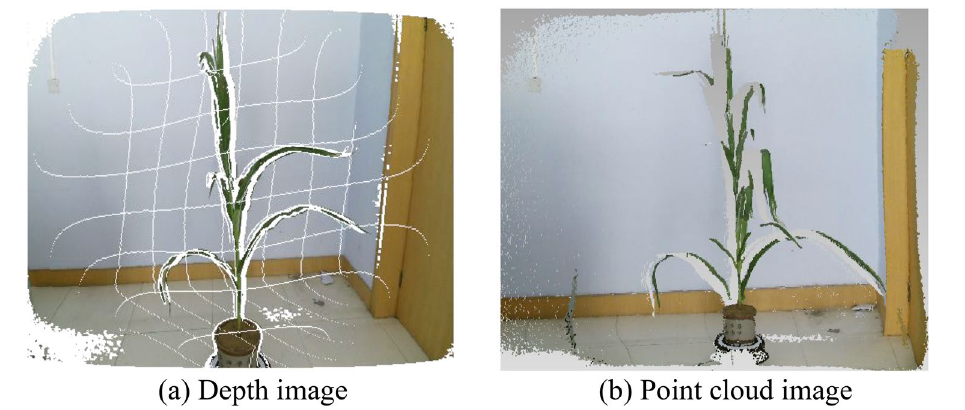
Figure 7. Depth map generates point cloud